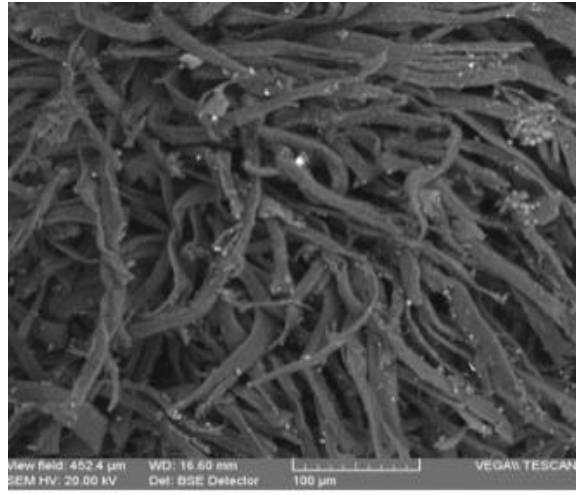
Figure 8. SEM microphotographs ( × 500, BSE) for the support of parchment S2, the degraded areas S2-S.